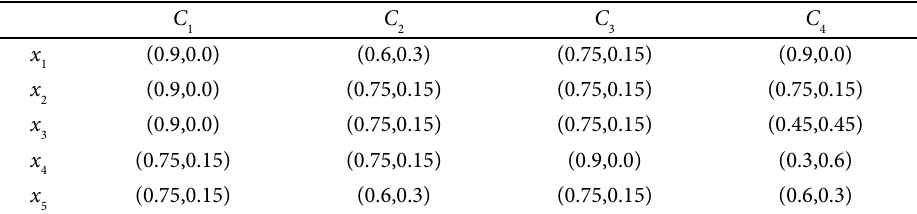
Table 1. Intuitionistic fuzzy decision